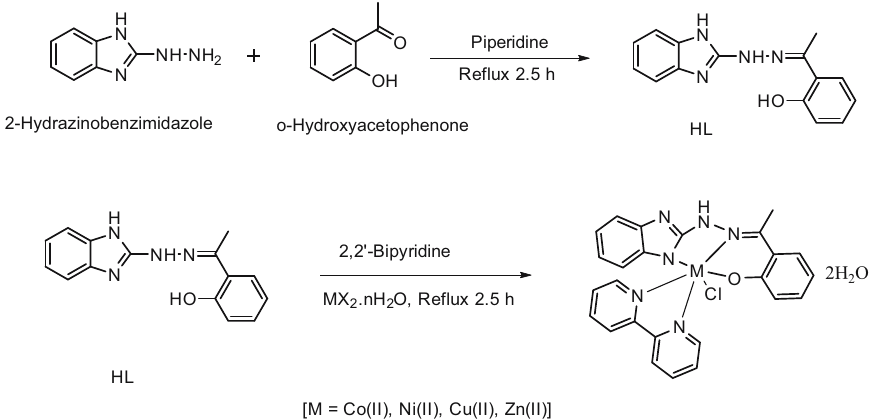
Scheme 1: Schematic representation of preparation of mixed - ligand